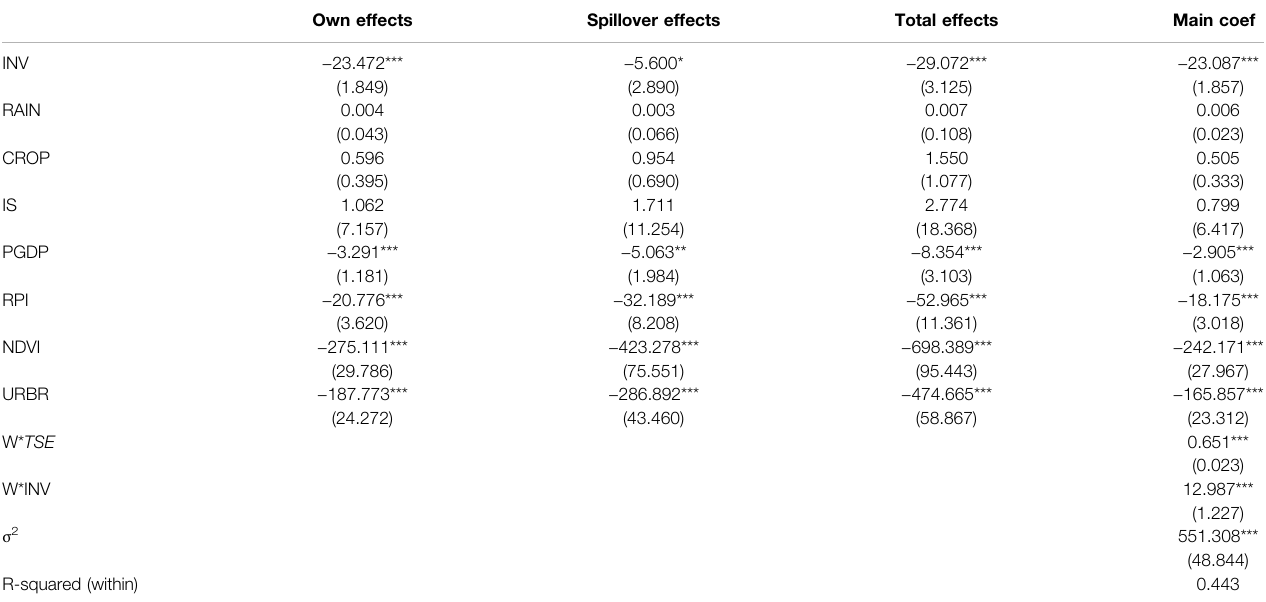
TABLE A1 | Estimation results of an SDM with a contiguity